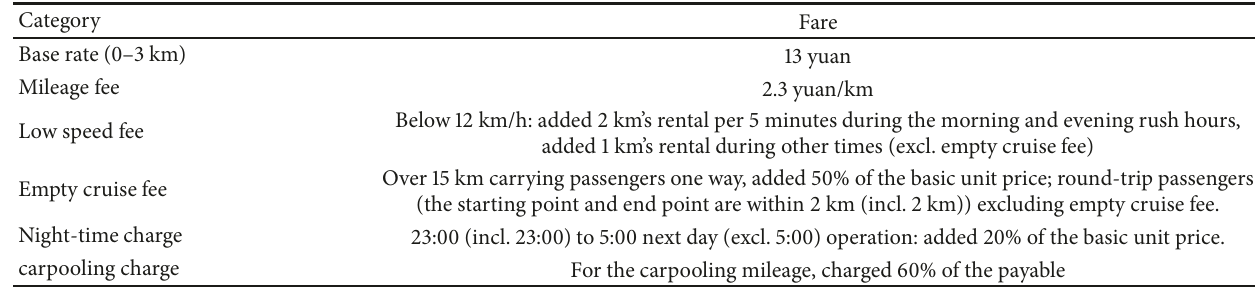
Table 1: Charge standard of Beijing